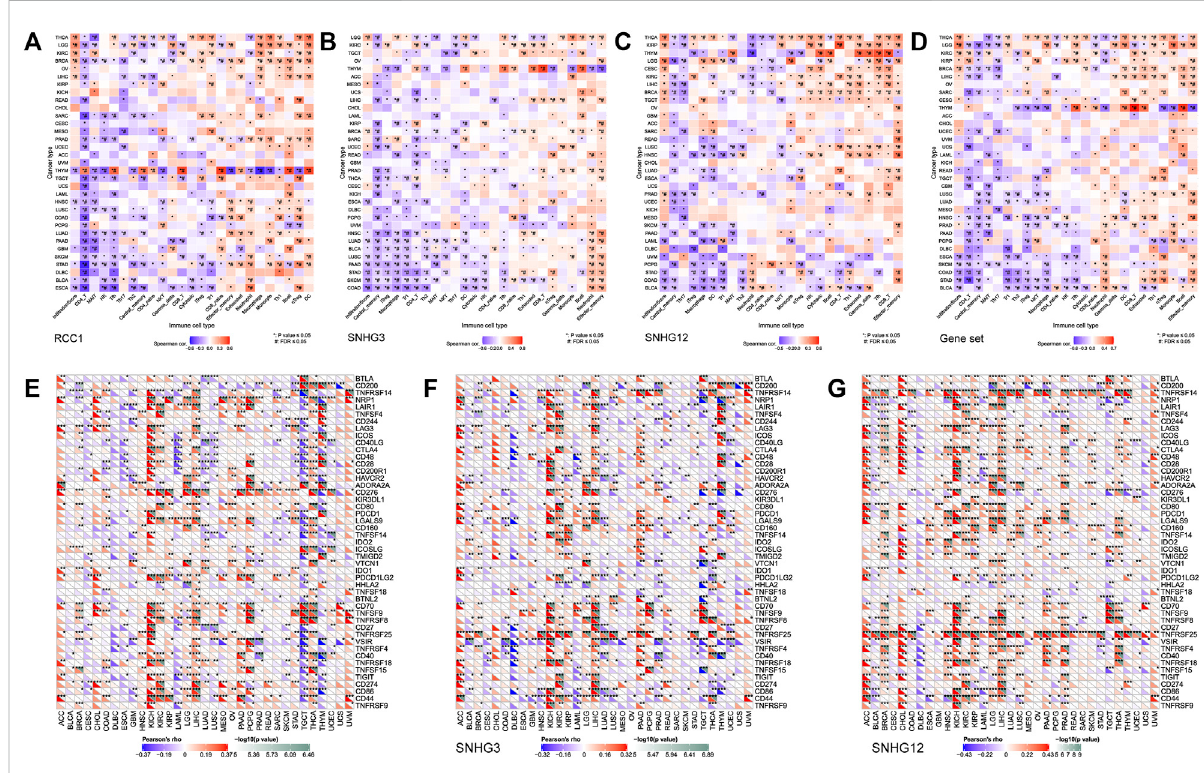
FIGURE 8 Association between RCC1/SNHG3/SNHG12 expression and immune in fi ltration and immune checkpoint genes expression in cancers. (A – D) Correlation of GSVA score with immune in fi ltration in different cancers. (E – G) Correlation of mRNA expression with immune checkpoint genes expression in different